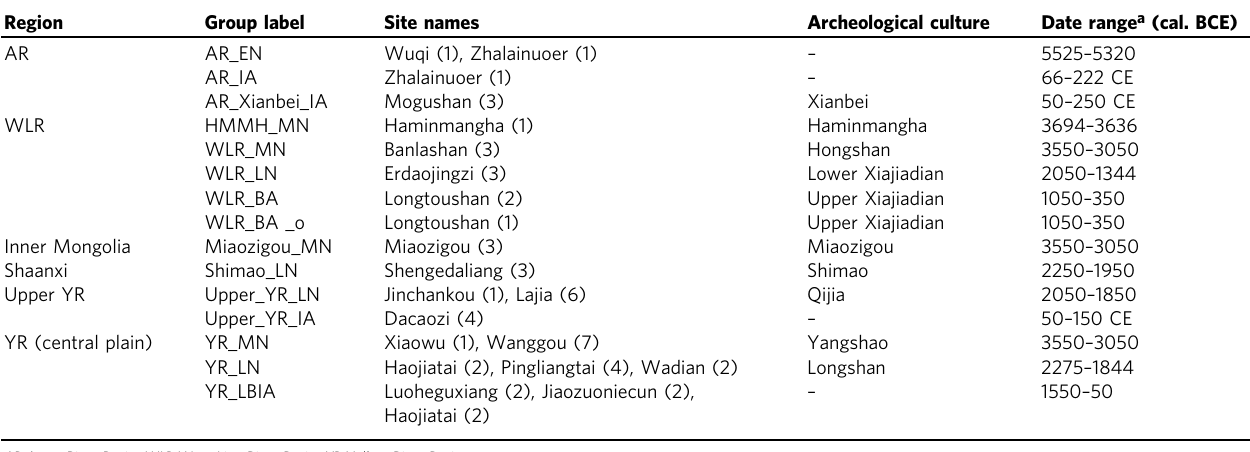
Table 1 Summary of ancient samples reported in this study. Region Group